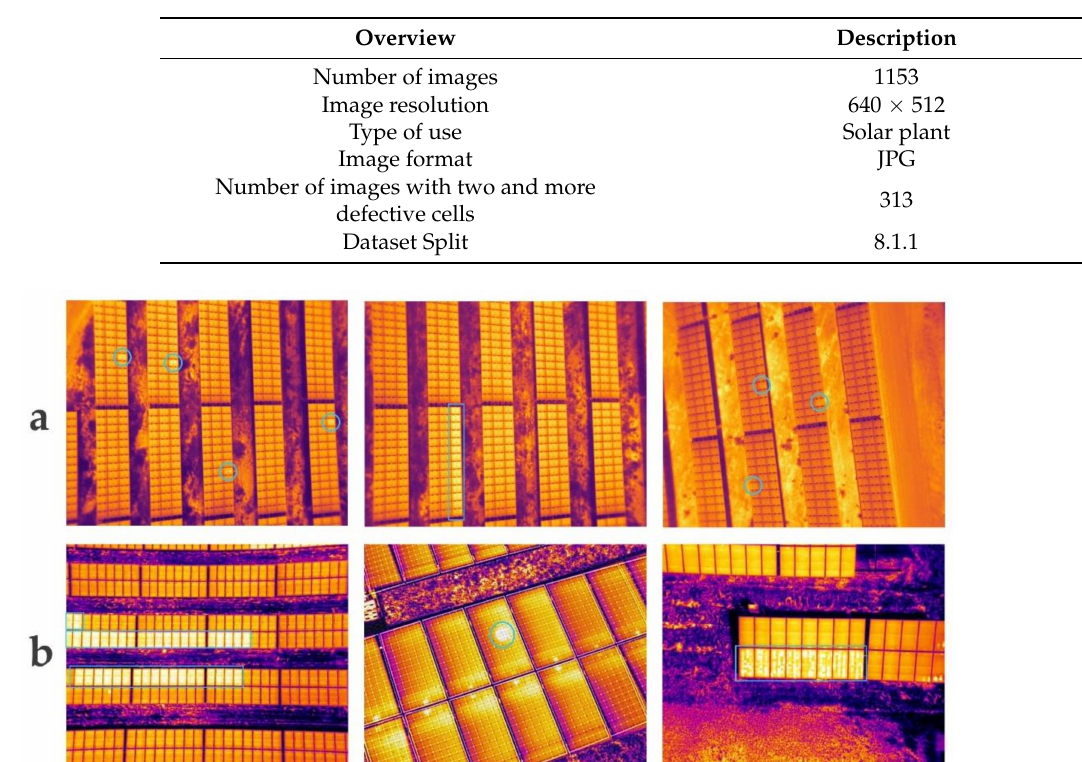
Table 2. Photovoltaic thermal image dataset (Combined).